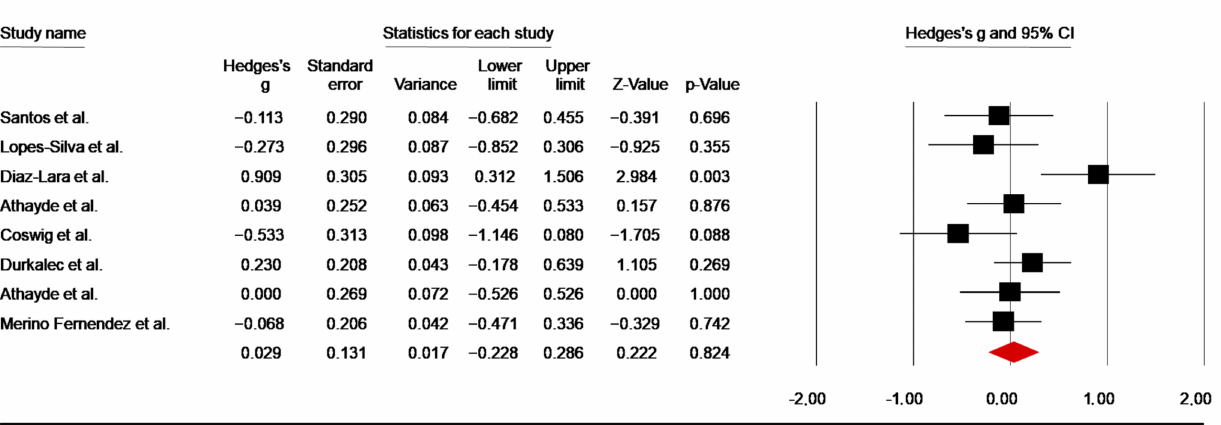
Figure 14. Forest plot of the effect of caffeine intake on number of offensives actions during combat